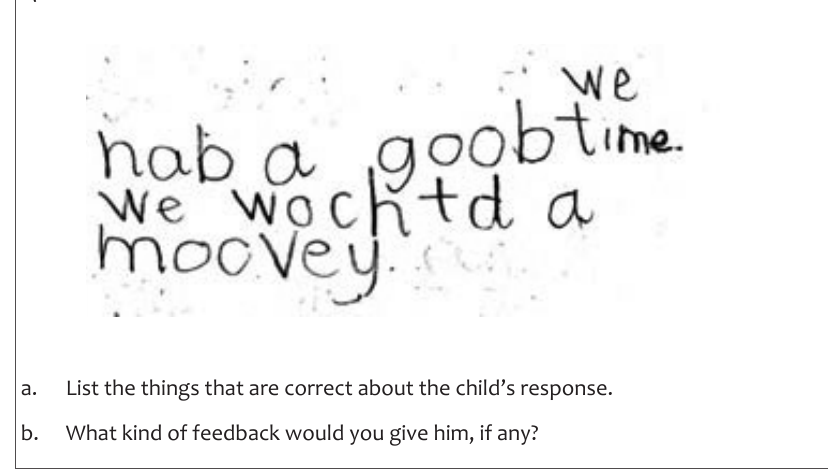
Figure 2: Question 16, designed to describe teachers’ ability to respond to learners’